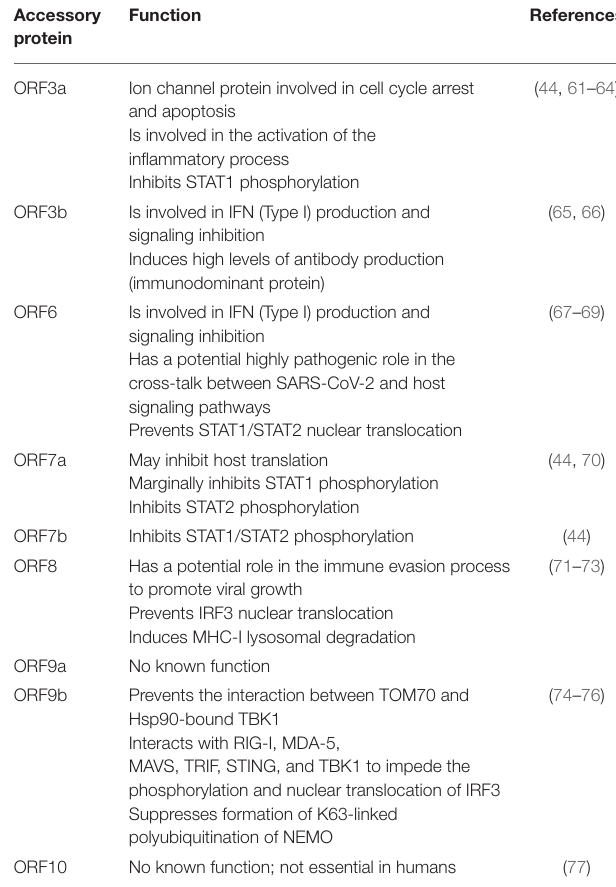
TABLE 3 | Accessory proteins encoded by SARS-CoV-2 genome and their functions. Accessory protein